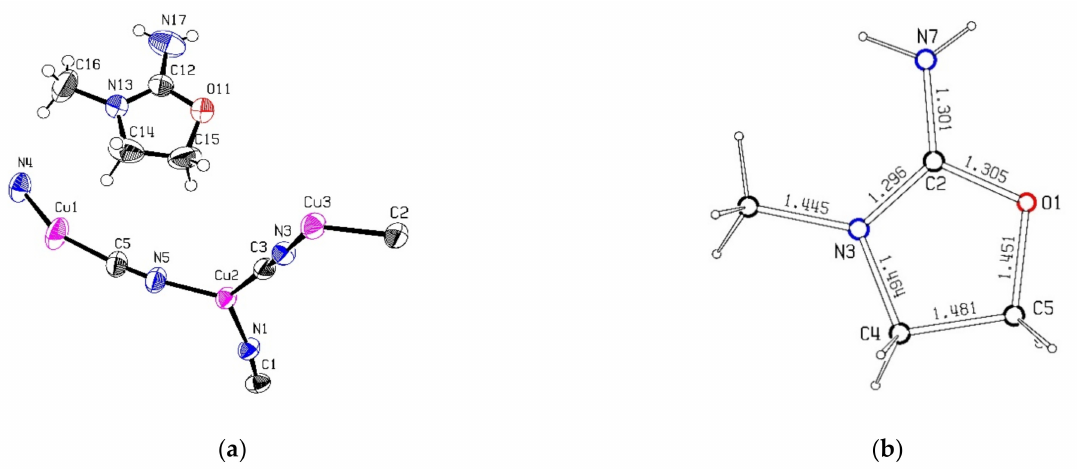
Figure 2. ( a ) Asymmetric unit for 1, showing thermal ellipsoids with 50% probability. Only one orientation of the disordered CN groups is shown. The CN groups C2 ≡ N2 and C4 ≡ N4 are each disordered about one of the inversion centers in the unit cell. ( b ) Bond lengths in the oxazolidin-2-iminium cation. Estimated standard deviations range from 0.004–0.007